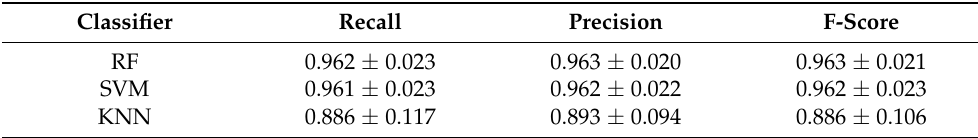
Table 2. Detection accuracy for each classifier.